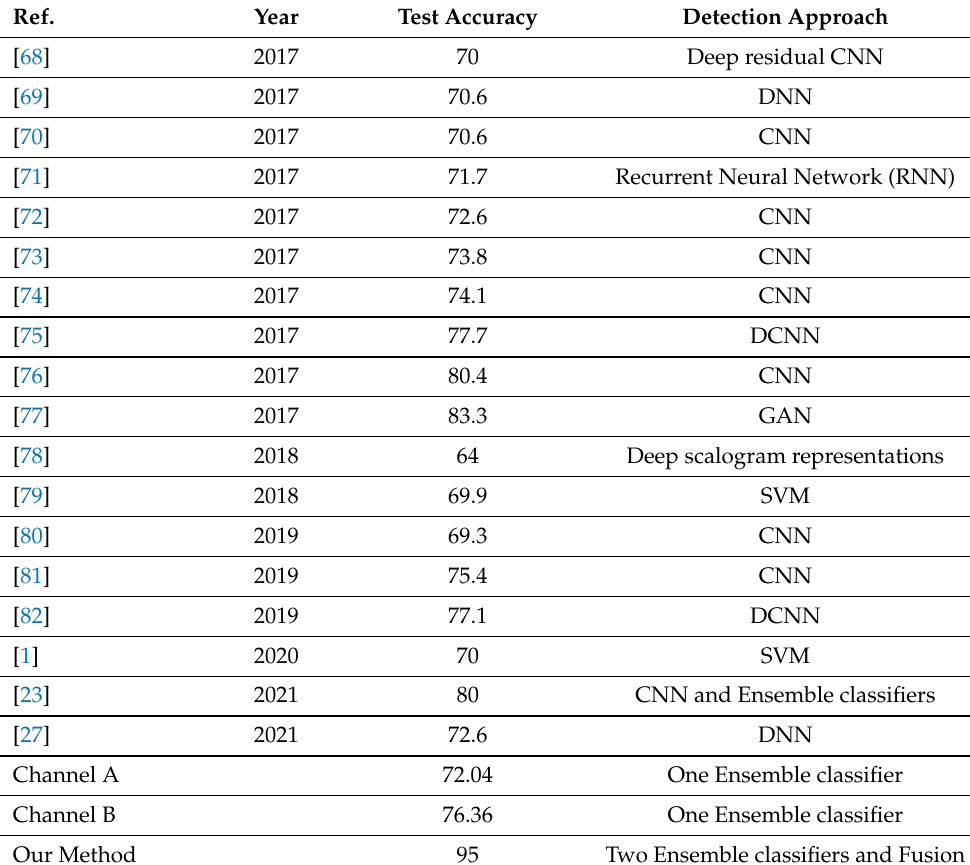
Table 2. Results of different ASC methods and of the proposed ASC method on the evaluation set of the DCASE 2017 dataset.